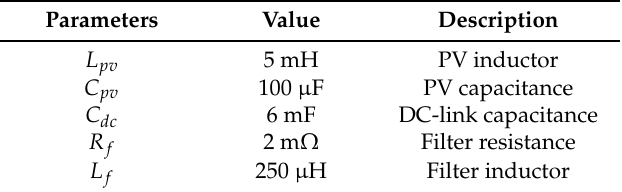
Table 1. The basic parameters of PV system.